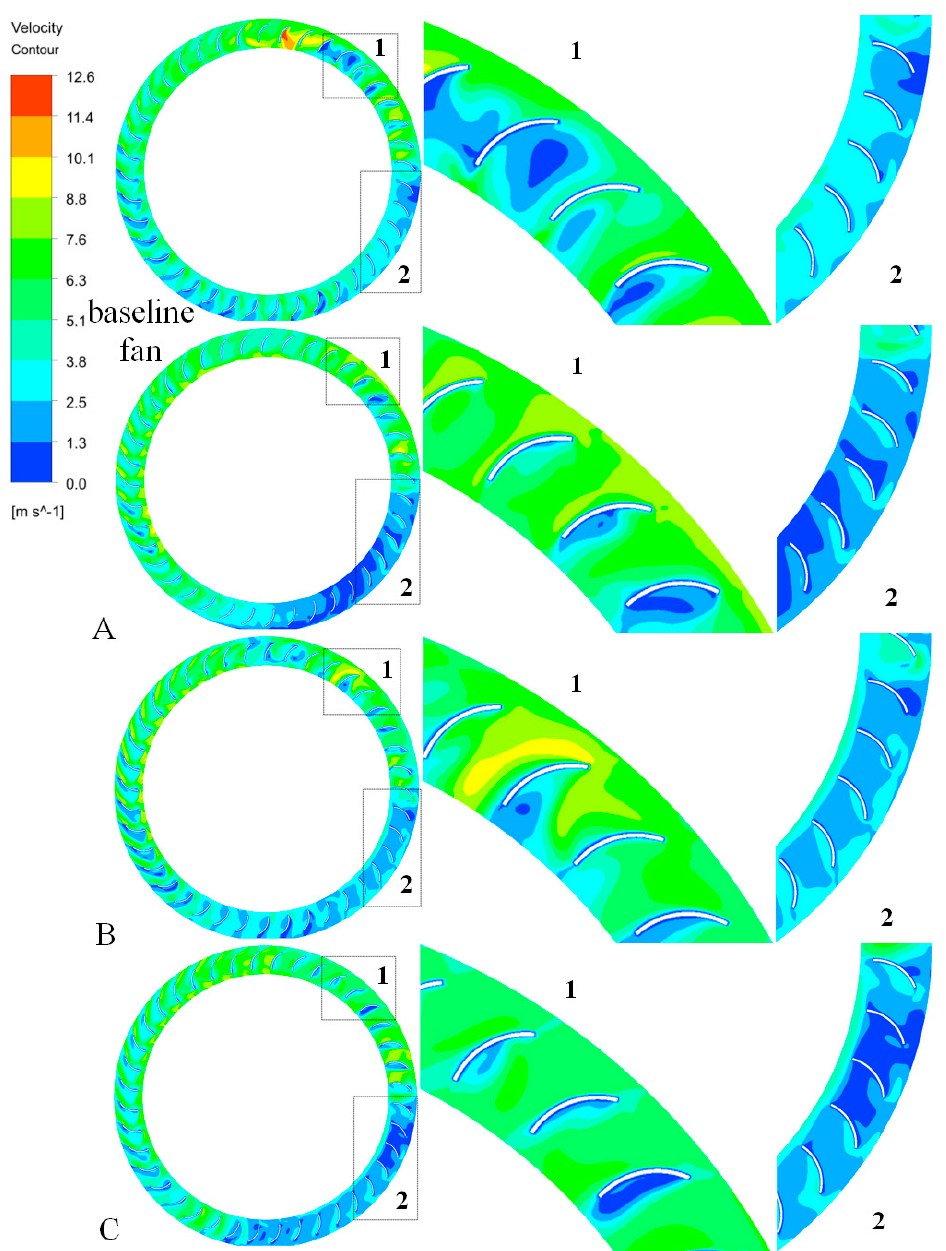
Figure 10. Magnitude of absolute velocity of the impeller for the z = 75 mm plane at a low flow rate Q / Q n = 0.483: ( A ) model-A; ( B ) model-B; ( C )